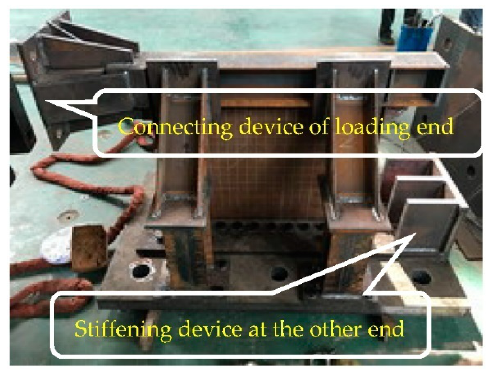
Figure 10. Detailed drawing of reinforcement for specimen 1.